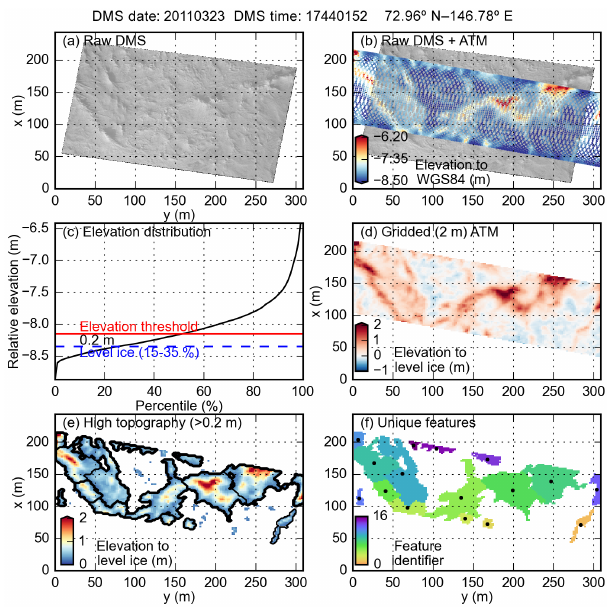
Figure 3. Example of the surface feature detection algorithm over- laid on a DMS image taken on the 23rd March 2011 as highlighted by the yellow star in Fig. 2. (a) DMS image; (b) raw ATM data overlaid on the DMS image; (c) elevation distribution for all ATM points within the section shown, where the blue line indicates the bounds of the calculated level ice surface and the red line indicates the feature height threshold; (d) gridded (2m) ATM elevation rel- ative to the level ice surface; (e) unique surface features ( > 20cm) and their elevation relative to the level ice surface; (f) unique surface feature identifier (features larger than 100m 2